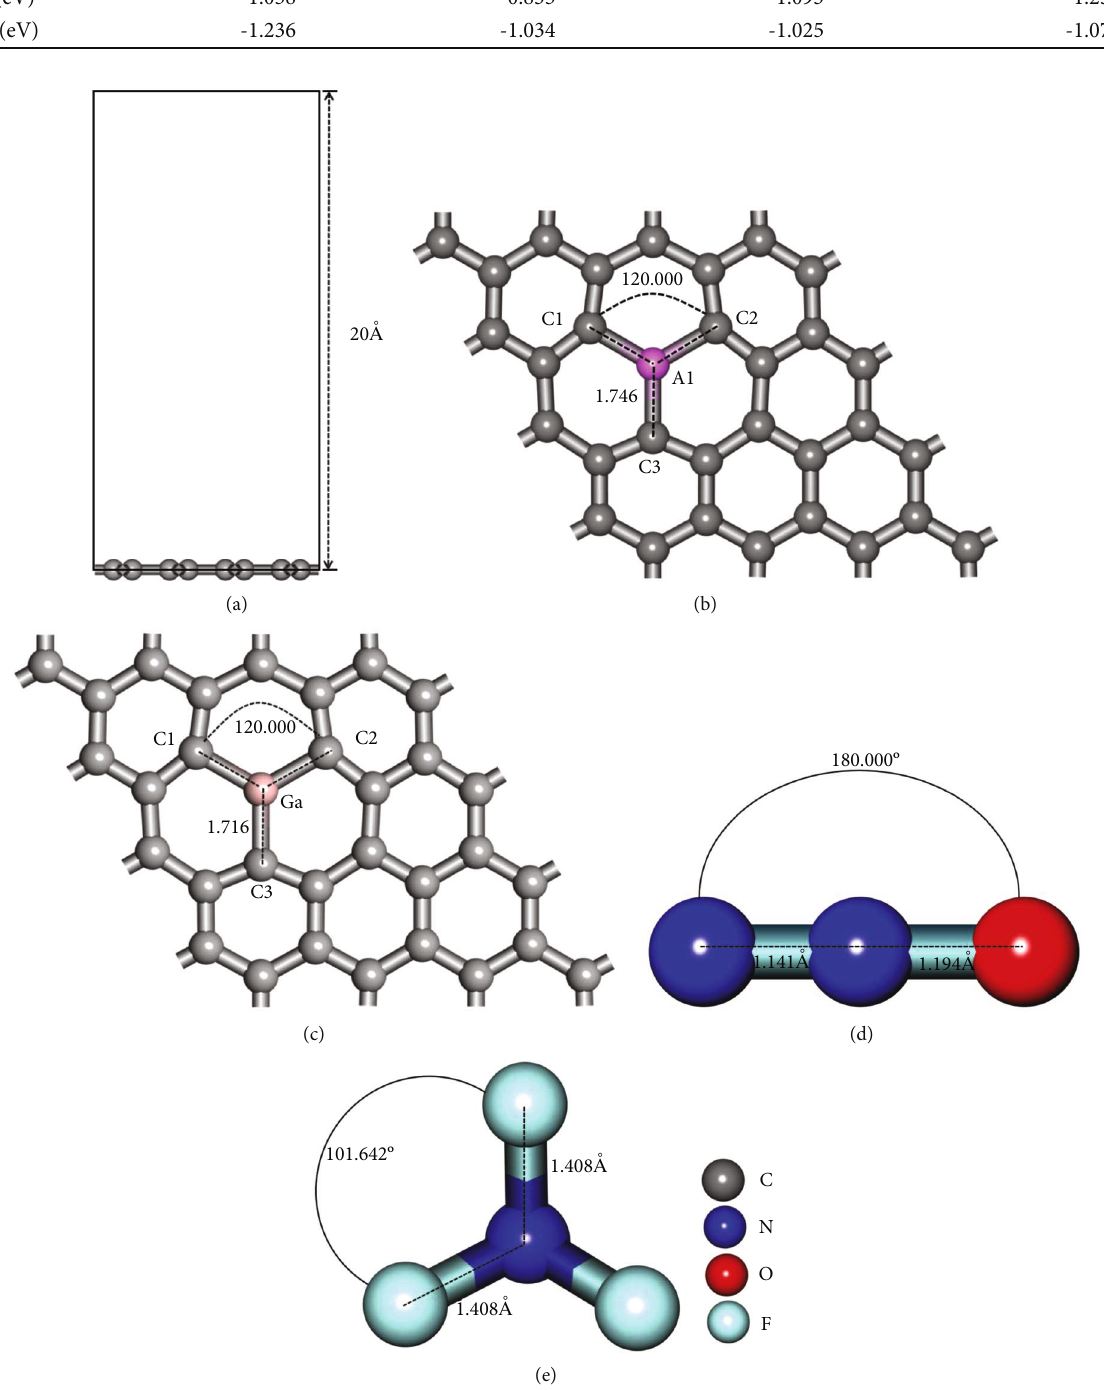
Figure 1: Geometry optimization structure of Al- and Ga-doped graphene, N of Al-doped graphene; (c) top view of Ga-doped graphene; (d) N